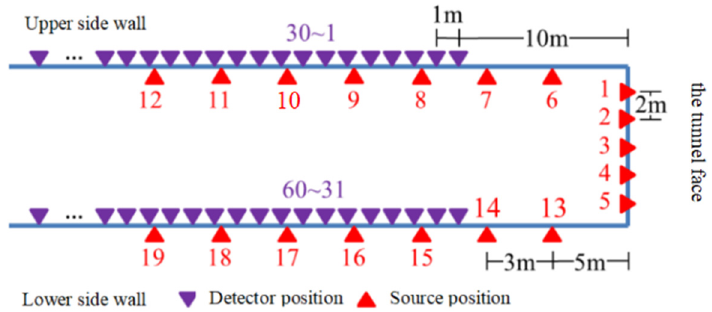
Figure 3. Schematic diagram of the observation system.